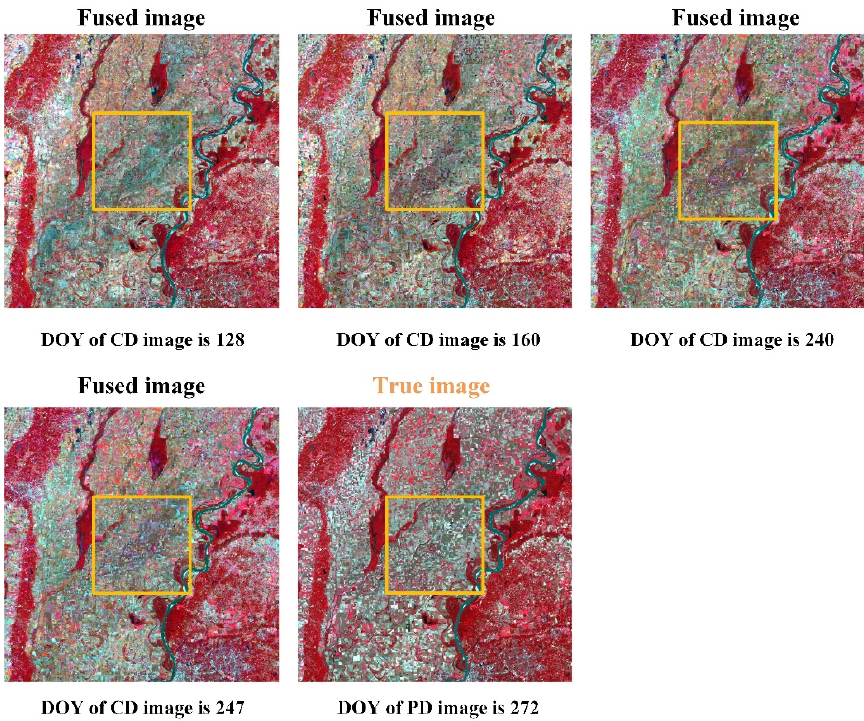
Figure 12. Standard false-color-composited images of the fused results with different input image dates for the NMC period and the true image (yellow box highlights a sub-region) .